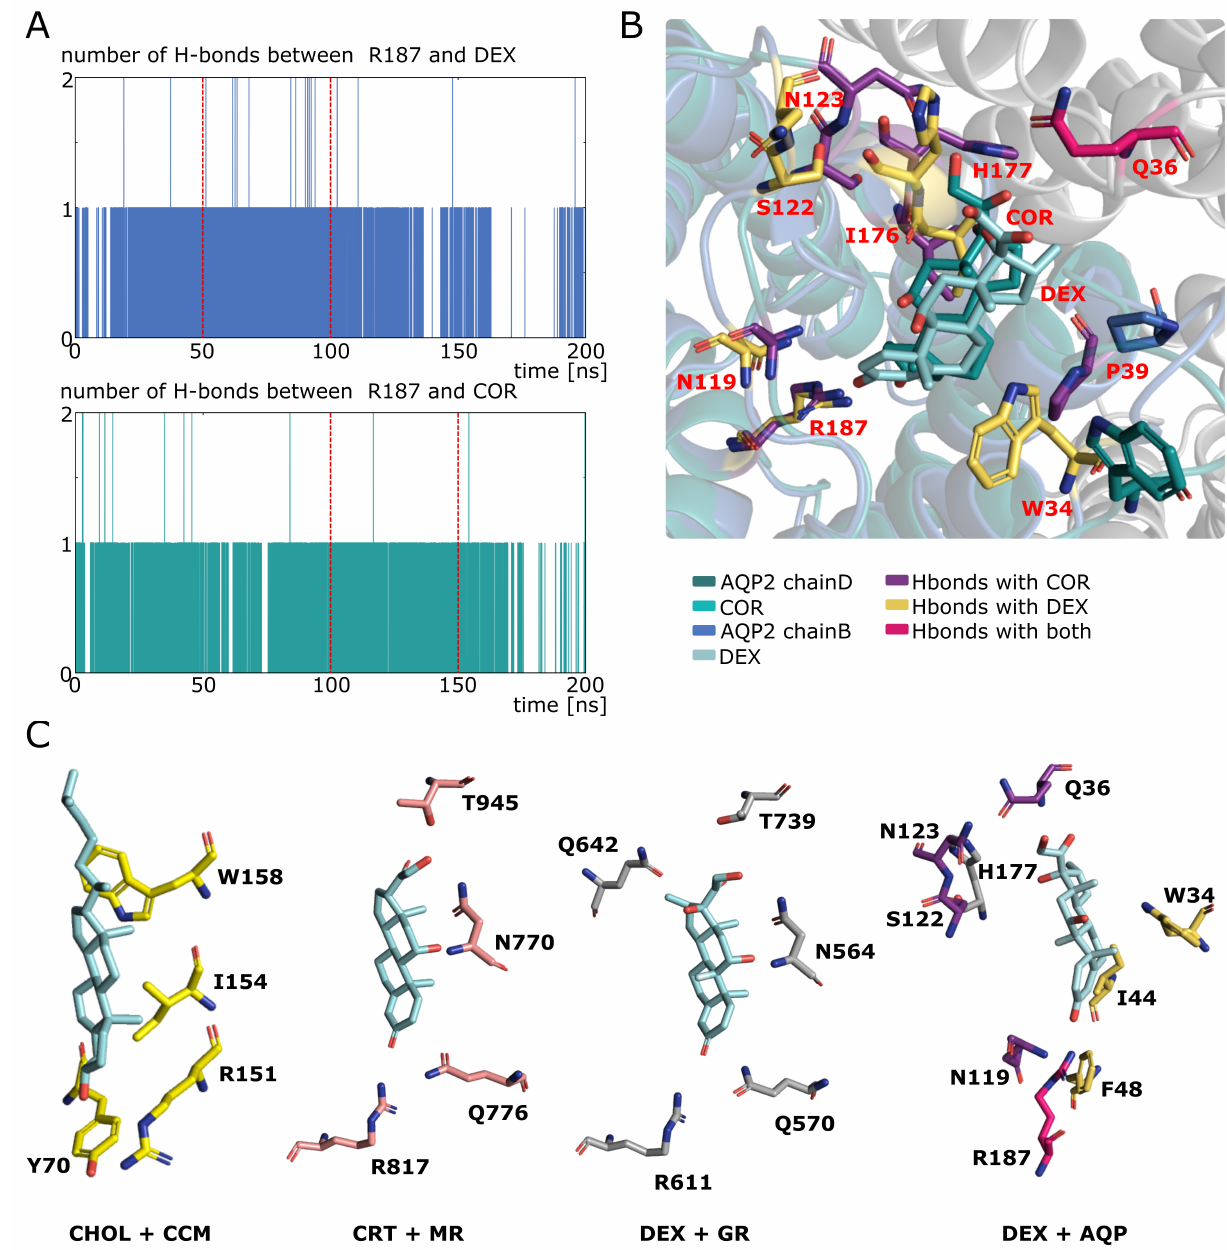
Figure 1. Functional homologies of Cholesterol Consensus Motif (CCM), Mineralocorticoid Receptor (MR) and Glucocorticoid Receptor with AQP2 extra-cellular vestibule. ( A ) Number of hydrogen bonds established between AQP2 chain B and dexamethasone (in blue) and between AQP2 chain